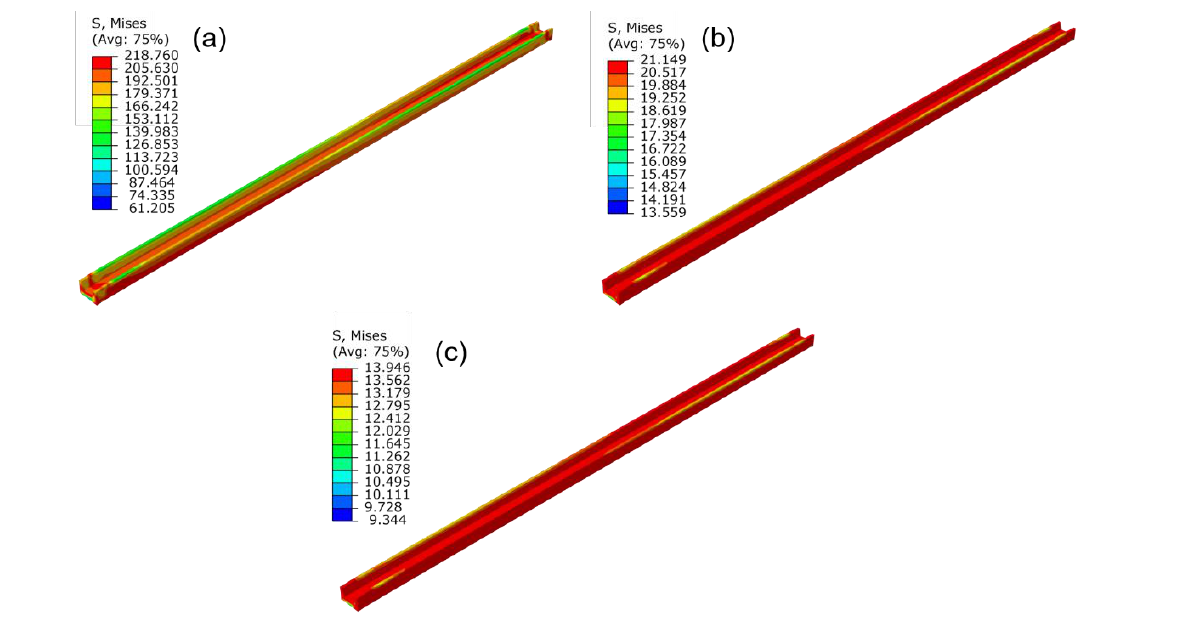
Figure 17. Influence of holding time on the stress distribution of the profile: ( a ) 0 s; ( b ) 600 s; ( c ) 1200 s (straightening temperature 700 °C, stretch strain 1.5%).